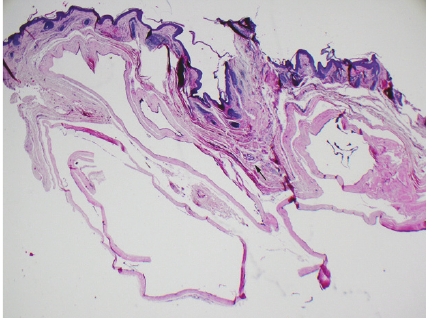
Figure 4: Histopathologic examination shows external auditory canal skin with multiple dermal cysts. A focus of normal sweat glands is present between the cysts in the middle of the photomi- crograph (arrow). Hematoxylin and eosin stain, 20x.